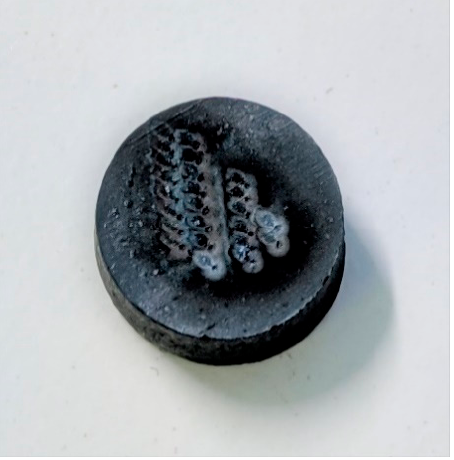
Figure 2. A pellet sample of 8 mm diameter was used as a sample for LIBS measurements.